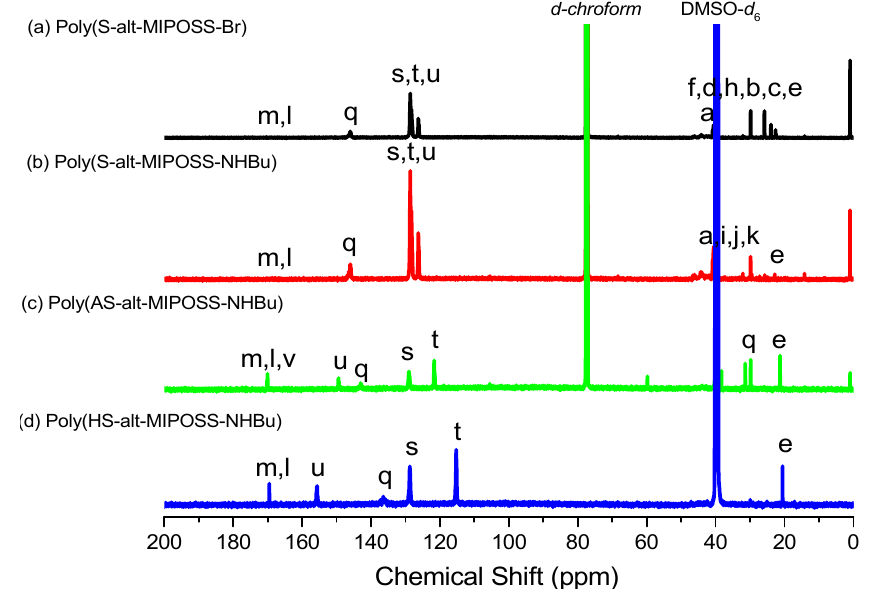
Figure 5. 13 C-NMR spectra of ( a ) poly(S- alt -MIPOSS-Br); ( b ) poly(S- alt -MIPOSS-NHBu); ( c ) poly(AS- alt -MIPOSS-NHBu); and ( d ) poly(HS- alt